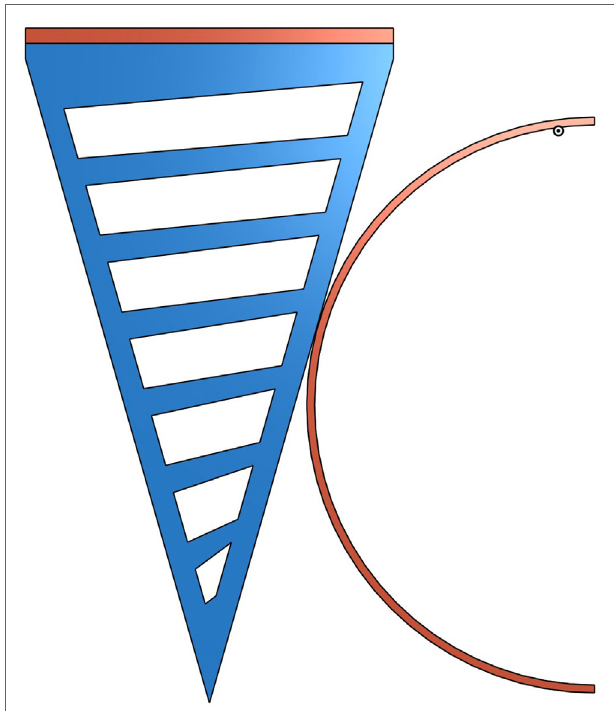
FigUre 5 | images showing the test setup for strength testing the grippers . The gripper was given a cup loaded with sand to grip. Opening and closing were controlled by a joystick connected to a myRIO. (a) Unloaded gripper. (B) Loaded gripper.